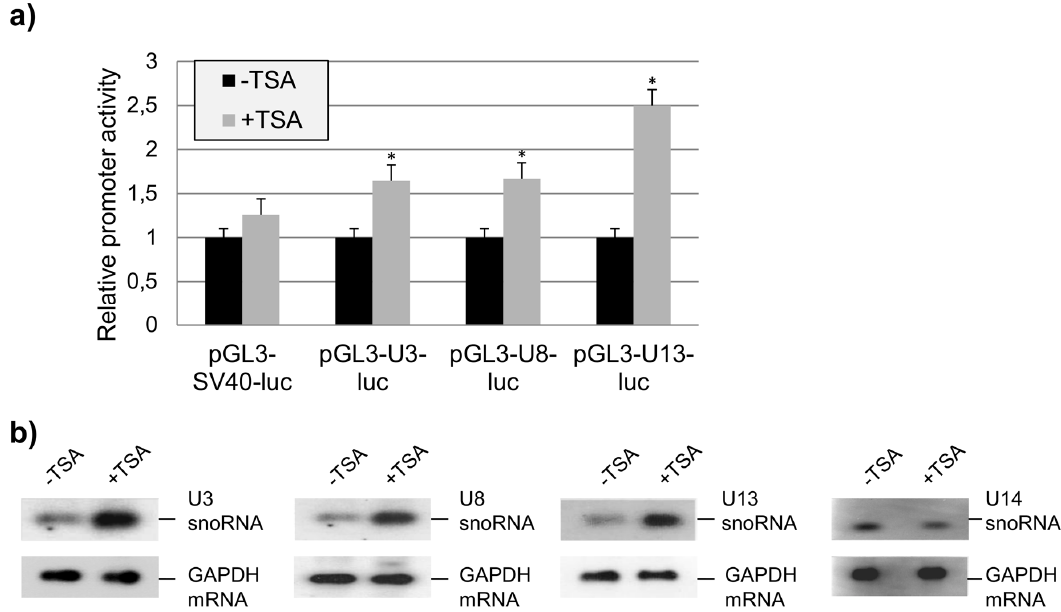
Figure 3. Effect of trichostatin A (TSA) on the expression of U3-, U8-, and U13snoRNA in HeLa cells. ( a ) TSA effect on the activity of isolated U3- and U8-gene promoters. Expression of firefly luciferase from plasmids pGL3-SV40-luc, pGL3-U3-luc, and pGL3-U8-luc was analyzed in cells treated with TSA (50 nM dissolved in dimethyl sulfoxide (DMSO) +TSA) or DMSO only ( − TSA) in the transient luciferase reporter assay, and is shown as relative promoter activity (mean ± SD; n = 3; * p value < 0.05); ( b ) TSA effect on the expression of U3-, U8-, U13-, and U14snoRNA from endogenous genes. Total RNA (5 µ g each) isolated from cells treated with TSA (50 nM in DMSO; +TSA) or DMSO only ( − TSA) were analyzed by Northern blotting with GAPDH mRNA monitoring as a loading control.